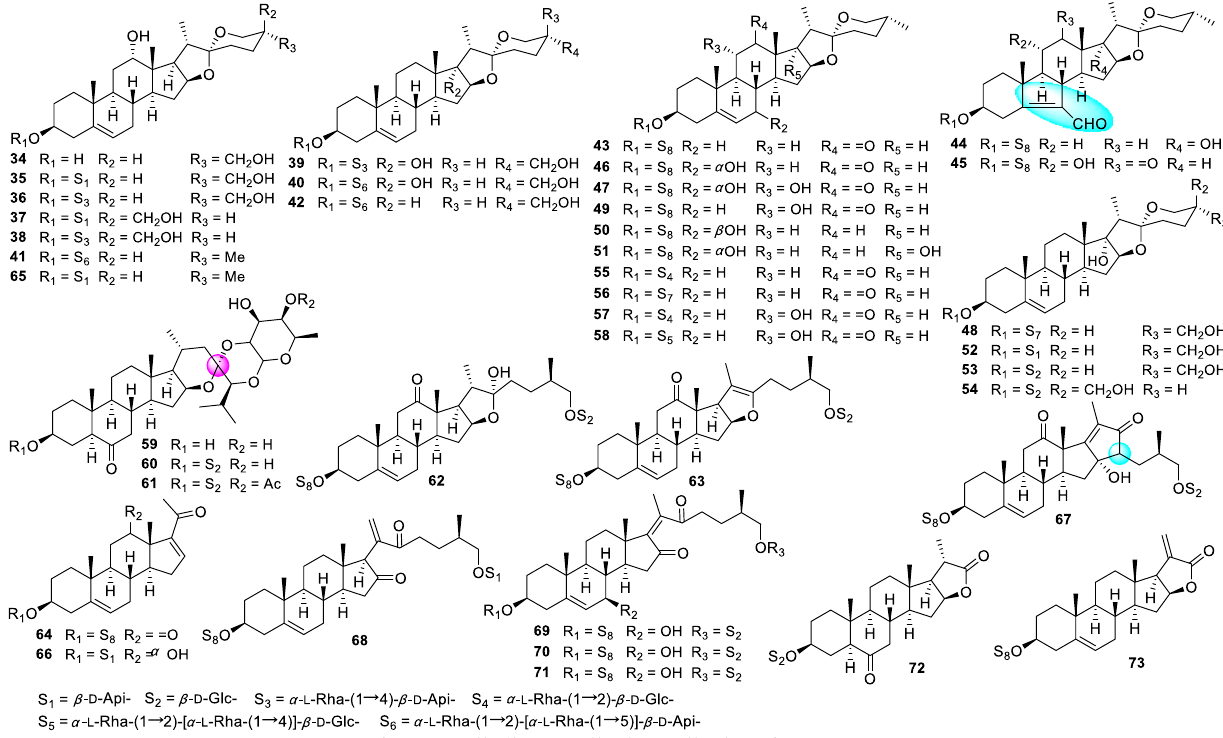
Fig. 2 New steroidal sapogenins and saponins from Ypsilandra